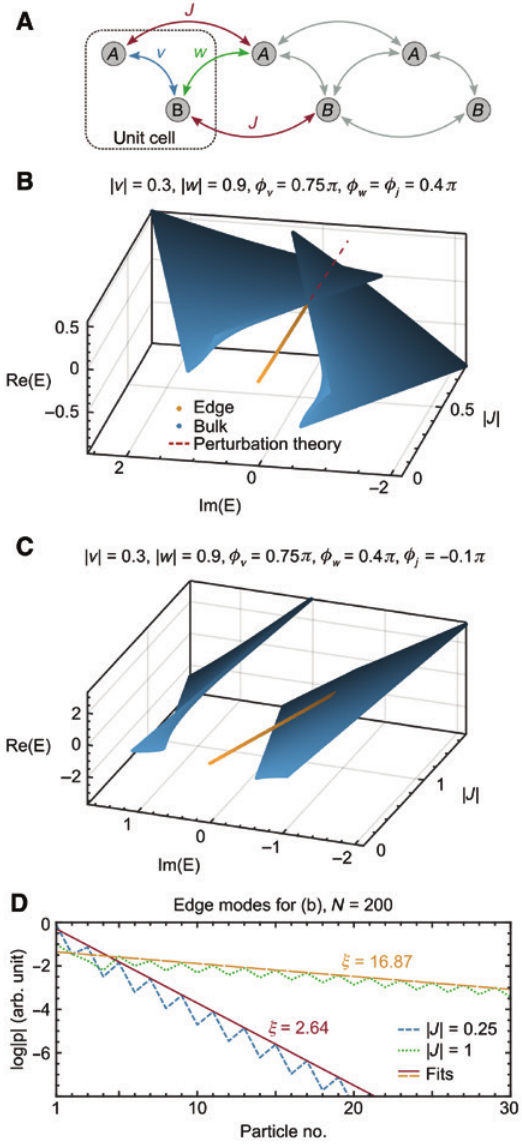
Figure 4: Diagram and eigenvalues of the non-Hermitian NNN SSH model. (A) The diagram of the next nearest neighbour SSH model with complex hopping v , w and J . (B) and (C) Bulk (blue) and edge mode (yellow) eigenvalues of the non-Hermitian NNN SSH model for changing values of | J |, for different choices of hopping parameters and phases in (B) and (C). The modes with larger | J | values are darker. The red dashed line is given by perturbation theory (see SM). (D) The edge mode profiles for the choice of parameters given in (c) for different choices of | J |. For real and imaginary projections see